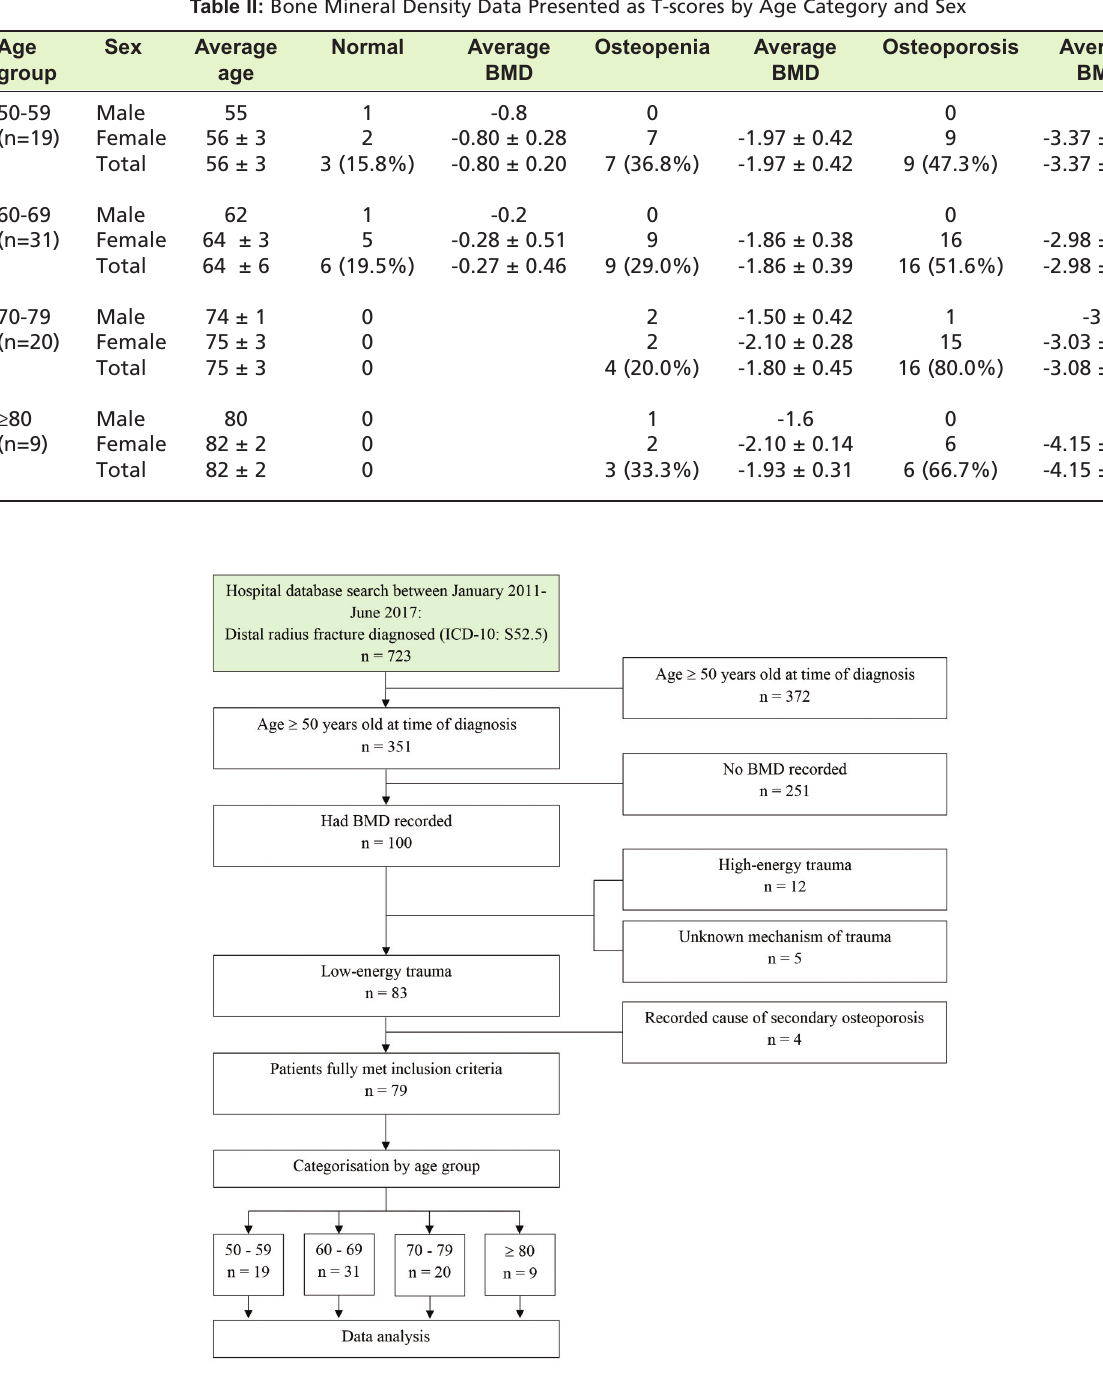
STROBE flow diagram of the Fig. 1: